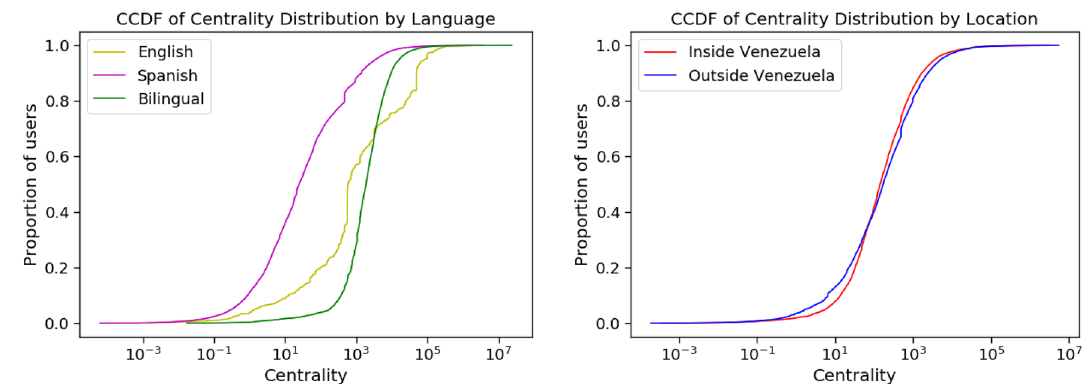
Figure 5. CCDF plots of the inter-community centrality of users from different language (left) and location (right) communities. We observe that language plays a much bigger role in determining user centrality than location